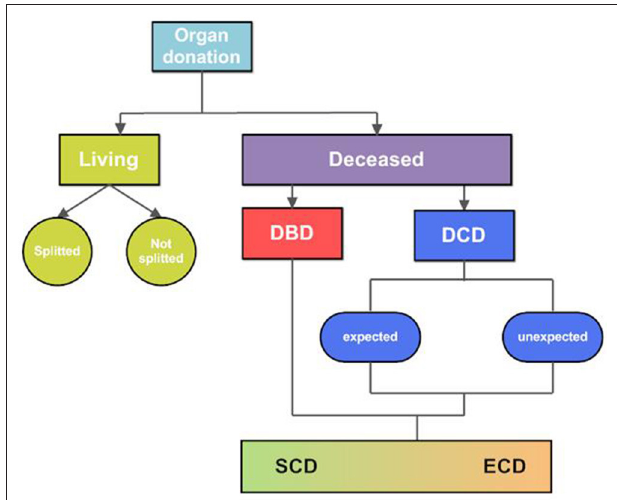
FIGURE 1 | Overview of donor types. Organs are retrieved from living and deceased organ donors. Organs from living donors can be donated partially, so-called “splitted” organ donation, or as a whole organ. The rest of the organs are retrieved from deceased donors, either from brain death (DBD) donors or circulatory death (DCD) donors. The DBD donor includes brain death with an intact circulation and preserved respiration. DCD donation